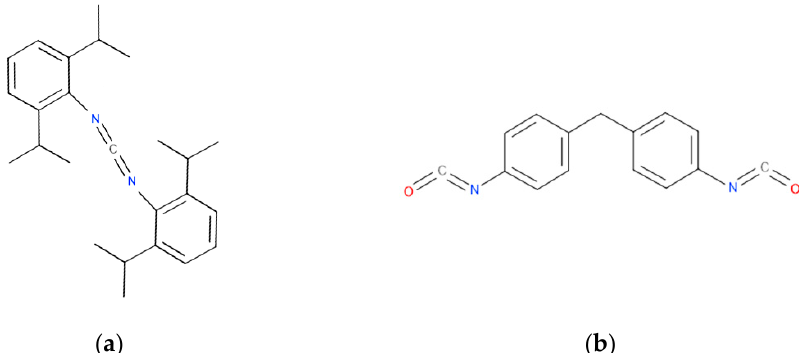
Figure 2. Chemical formula of chain extenders (CE): bis(2,6-diisopropylphenyl)carbodiimide (KI) ( a ) and 4,4 ′ -Methylenebis(phenyl isocyanate) (MDI) ( b ).